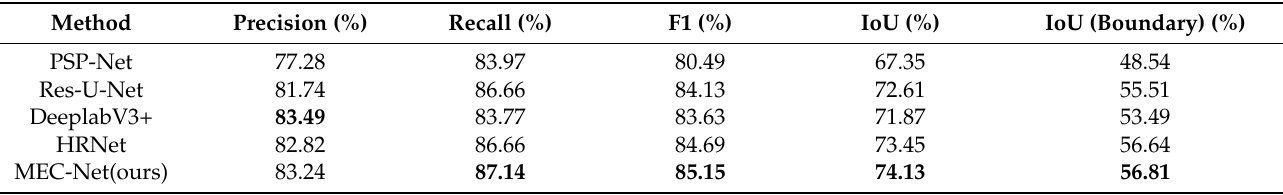
Table 3. Quantitative evaluation of MEC-Net using the Massachusetts